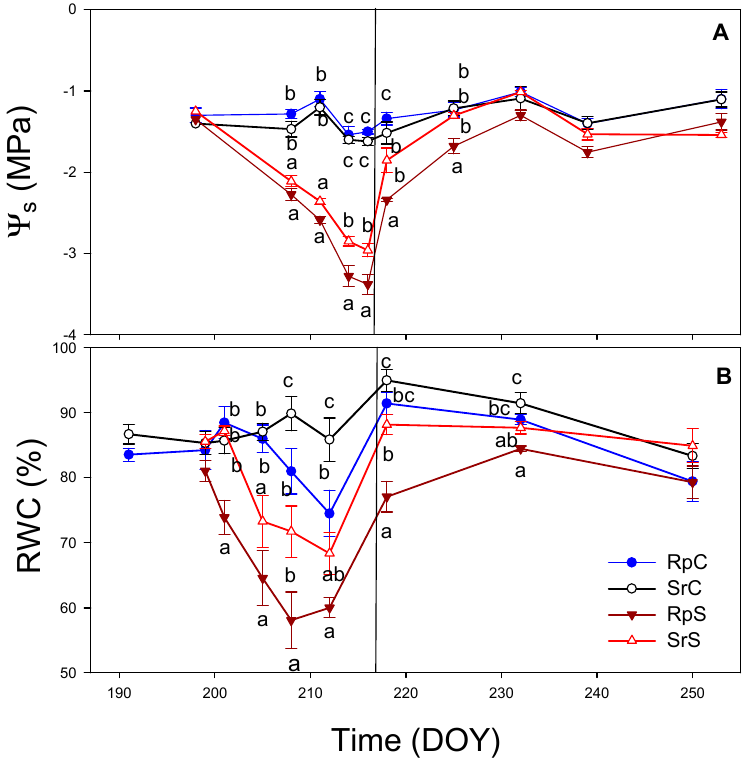
Figure 4. Evolution of the stem water potential ( Ψ s , ( A )) and leaf relative water content (RWC, ( B )) in P. dulcis plants submitted to different treatments. Values are means + s.e., n = 6. Symbols represent the different treatments: RpC (filled circles; plants grafted under full irrigation), SrC (open circles; self-rooted plants under full irrigation), RpS (filled triangles; plants grafted submitted to water stress) and SrS (open triangles; self-rooted plants submitted to water stress). Different lowercase letters indicate significant differences between treatments according to Duncan 0.05 test. Vertical line indicates irrigation change, the end of the water stress period and the beginning of recovery period.